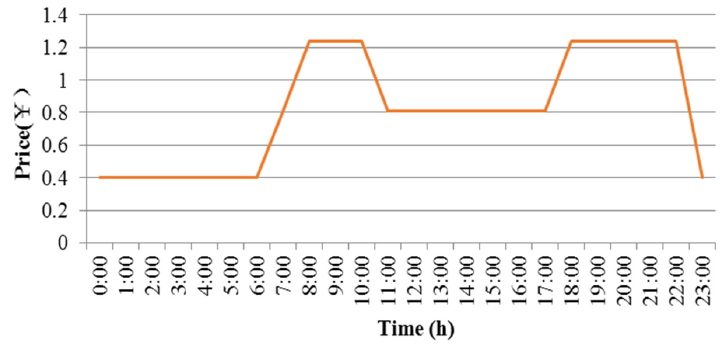
Figure 4. The price of electricity of a city.